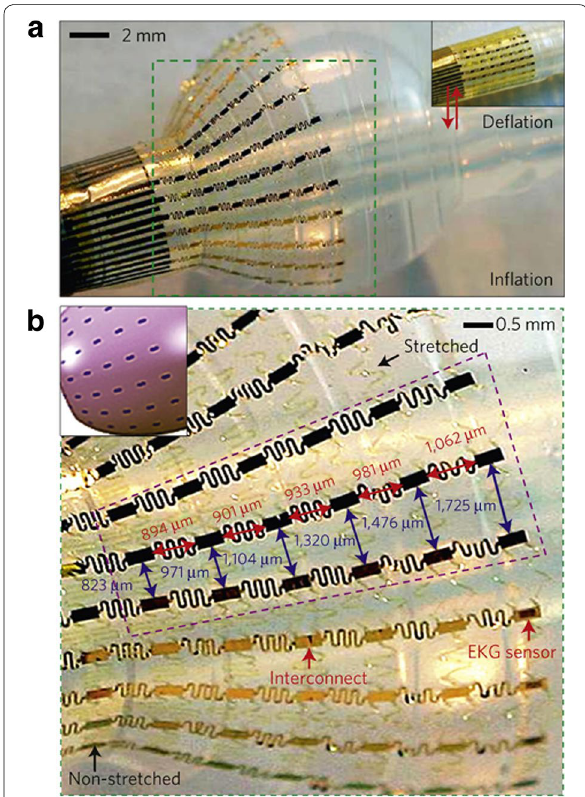
Fig. 1 Multifunctional inflatable balloon catheters. a Image of inflatable catheter (130% inflation) with contraction and ( upper right ) inflated state. b An enlarged image of an inflated balloon catheter ( green dotted area in a ) (Reproduced with permission from Ref.